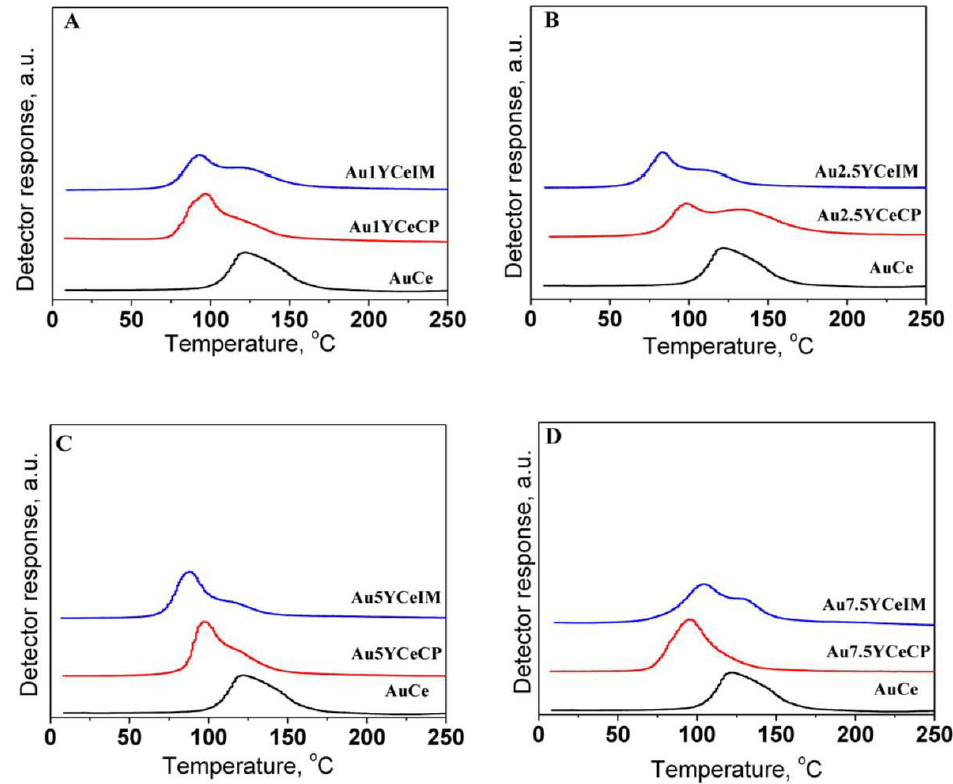
Figure 5. TPR profiles of the studied gold catalysts in the temperature interval of ceria surface layer reduction: ( A ) Catalysts containing 1 wt. % dopant and AuCe as a reference; ( B ) Catalysts containing 2.5 wt. % dopant and AuCe as a reference; ( C ) Catalysts containing 5 wt. % dopant and AuCe as a reference; ( D ) Catalysts containing 7.5 wt. % dopant and AuCe as a reference.